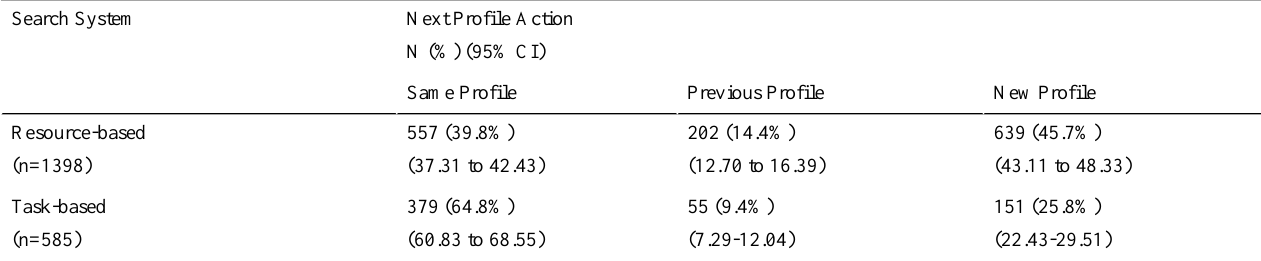
Table 3. Comparison of next profile actions between resource-based and task-based systems